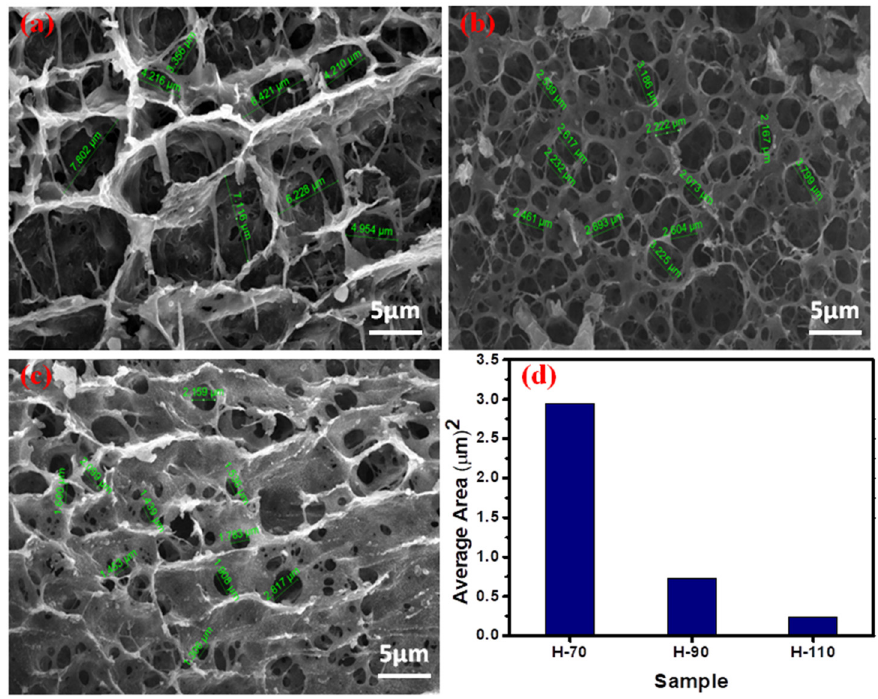
Figure 4: SEM images of hydrogel: ( a ) H - 70; ( b ) H - 90; ( c ) H - 110; and ( d ) histogram of the area of